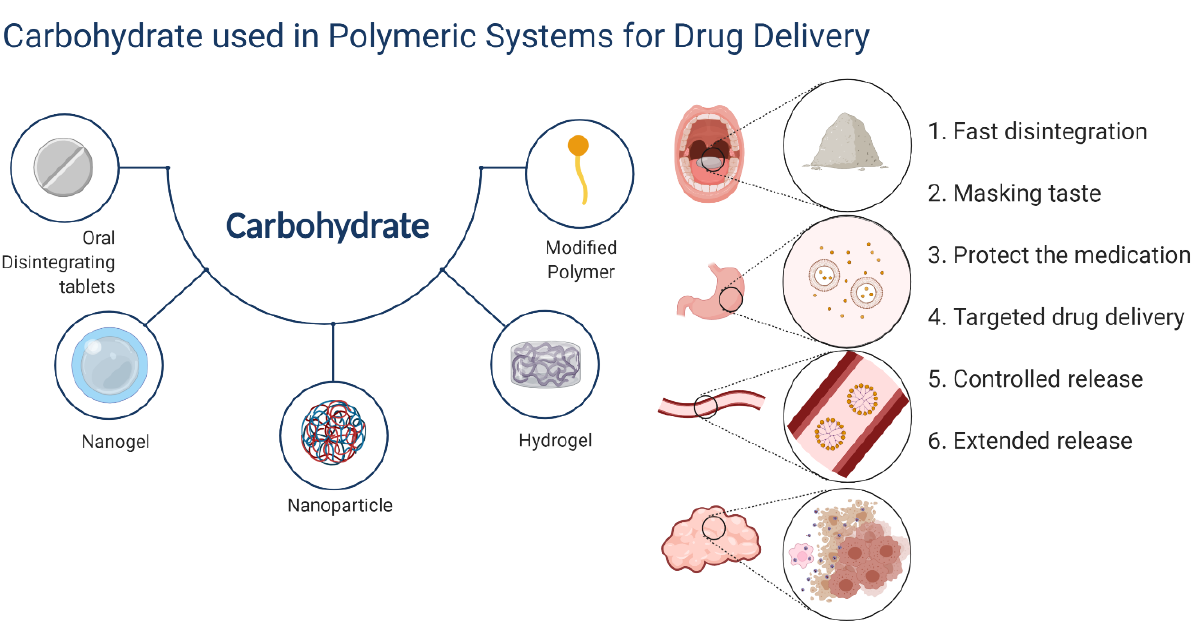
Figure 1. Carbohydrates used in polymeric systems for drug delivery.